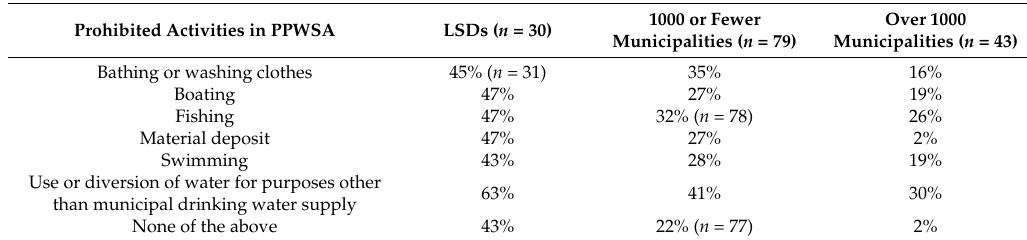
Table 1. Non-Compliance with prohibited activities under Protected Public Water Supply Area (PPWSA) regulations